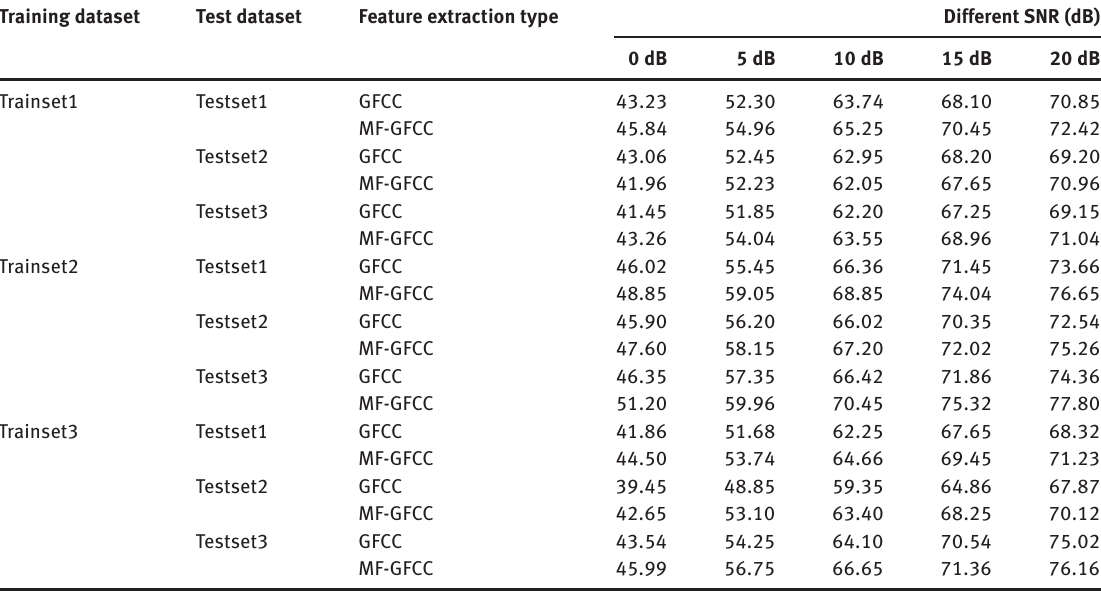
Table 2: Comparative Analysis with Different SNRs. Training dataset